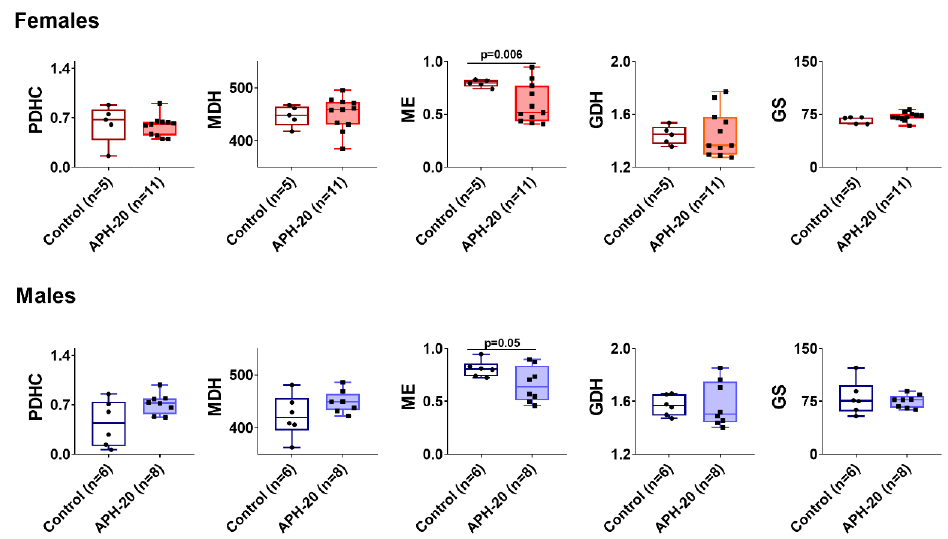
Figure 5. Influence of acute prenatal hypoxia on the 20th day of gestation (APH-20) on cerebral cortex enzymes in the male and female offspring of rats. The activities (micromole/min per g of tissue) are presented as the means ± SEM. p -values shown on the graphs, are determined using unpaired t -test with Welch’s correction. PDHC—pyruvate dehydrogenase complex, MDH—malate dehydrogenase,